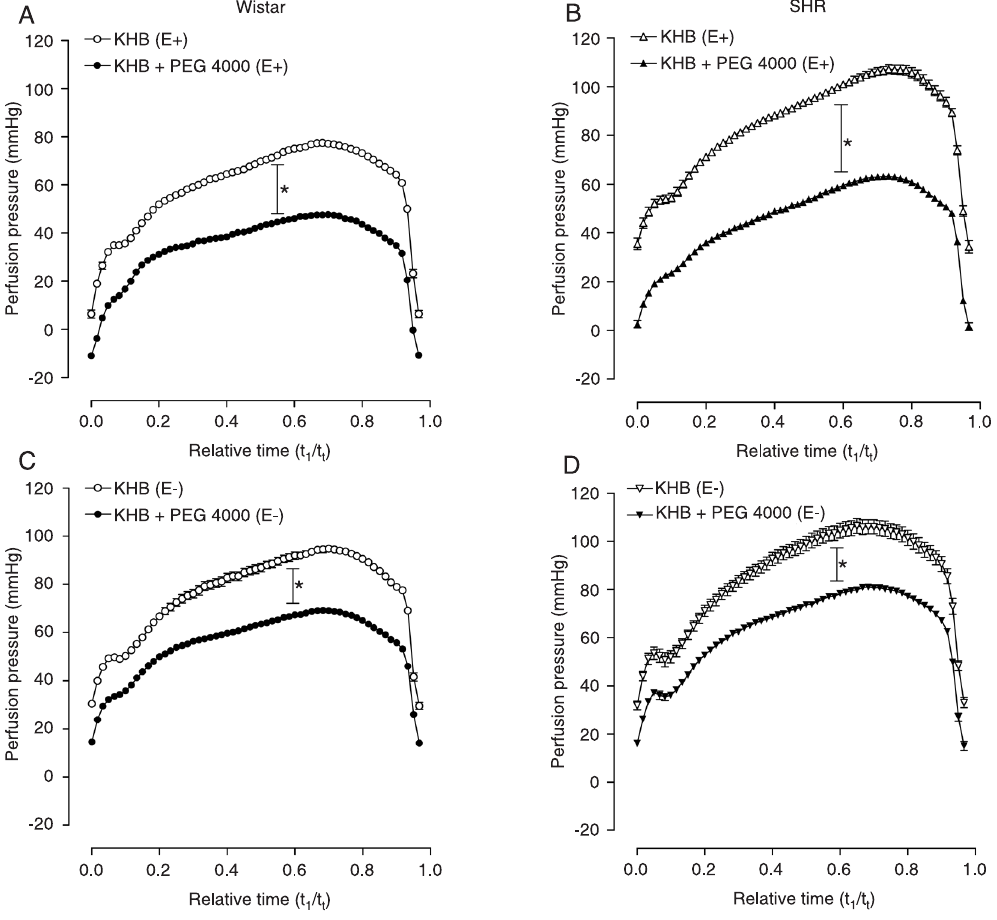
Figure 2. Effect of PEG 4000 perfused at the flow rate of 2.5 mL/min on the pulsatile pressure acquired from tail arterial beds with intact endothelium (E+) (A and B, respectively) and after endothelial damage (E-) of Wistar rats and spontaneously hypertensive rats (SHR) (C and D, respectively). KHB = Krebs-Hanseleit-buffered solution. Relative time was calculated as actual time (t 1 ) divided by total time (t t ). N = 4-6 animals in each group. *P < 0.05 for KHB vs KHB + PEG (paired Student t -test). Differences were analyzed concerning peak pressure, delta of pulsatile pressure, and area under the pressure